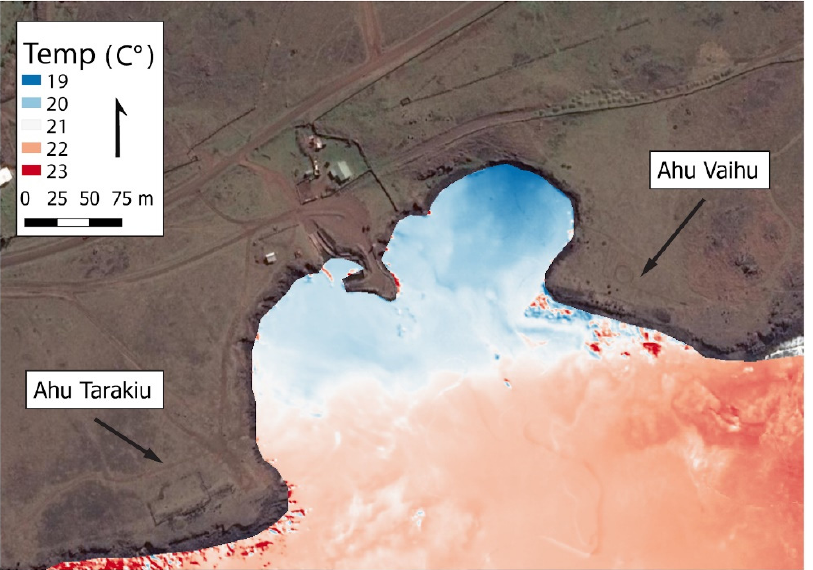
Figure 3. Thermal image of submarine groundwater discharge at Hange Te‘e, showing the locations of two large ahu (ceremonial statue platforms), Ahu Vaihu and Ahu Tarakiu.